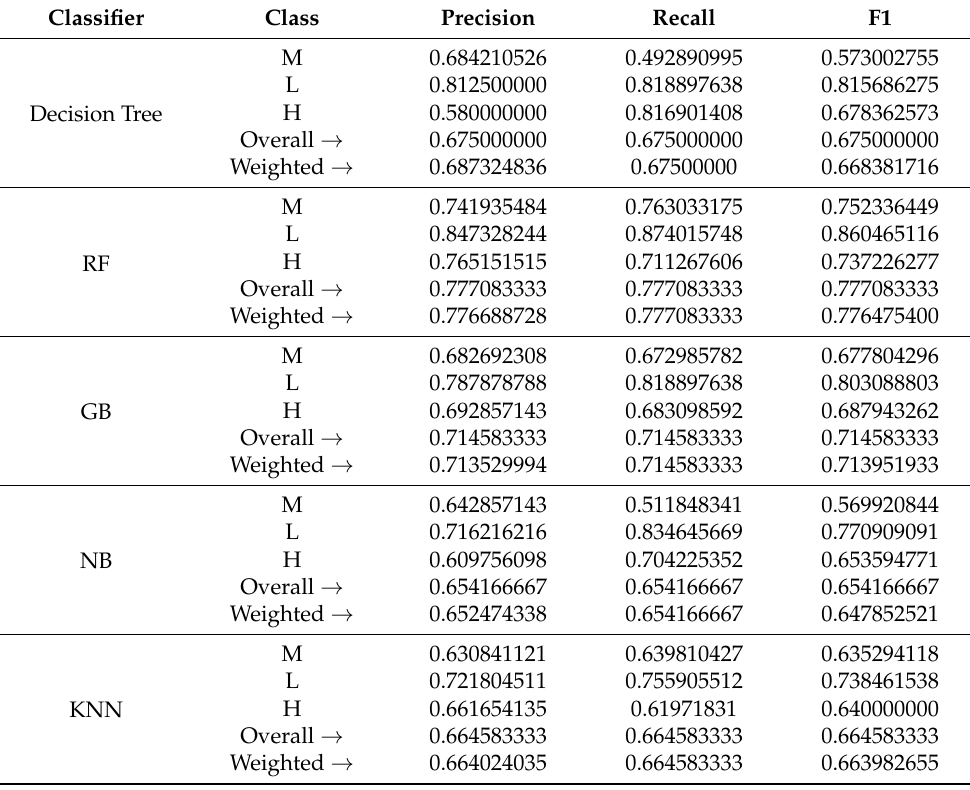
Table 3. Performance metrics for all ML models—without ensemble method.